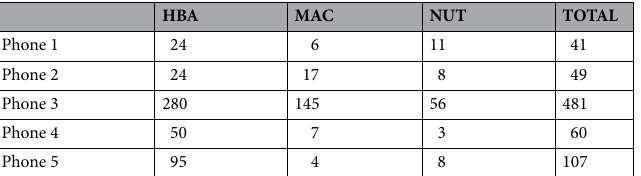
Table 1. Number of individual agar plate derived colonies retrieved from each phone swab. A total of 15 agar plates (5 HBA, 5 MAC and 5 NUT) were used to grow swabs derived from community phones (n = 5). Pooled colonies for HBA, MAC and NUT accounted for 473, 179 and 86 colonies respectively (Each pool was subject for downstream shogun